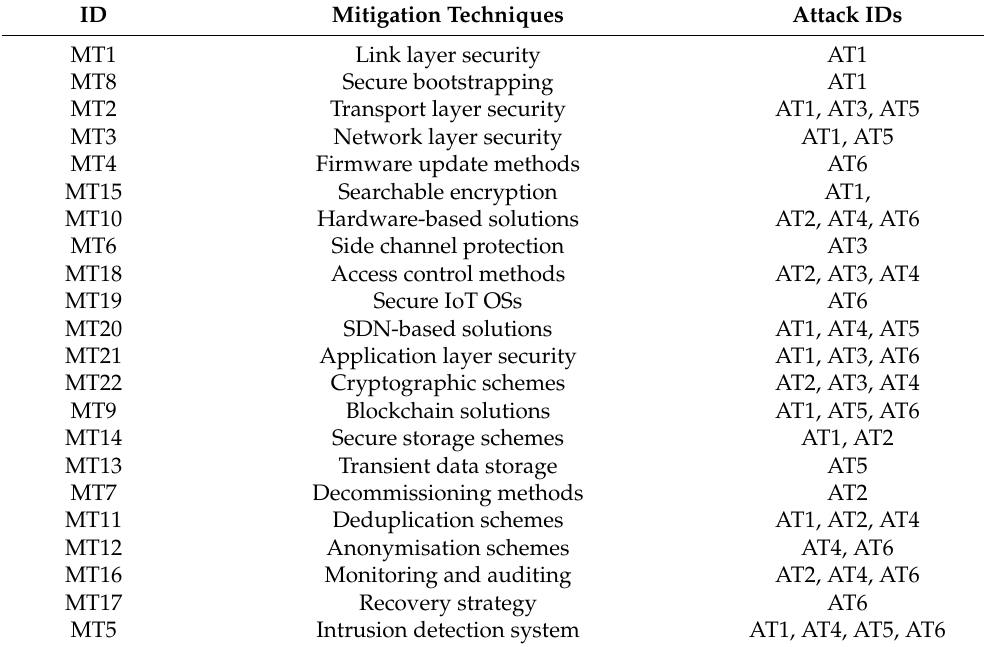
Table 3. Attack vector correlation to mitigation